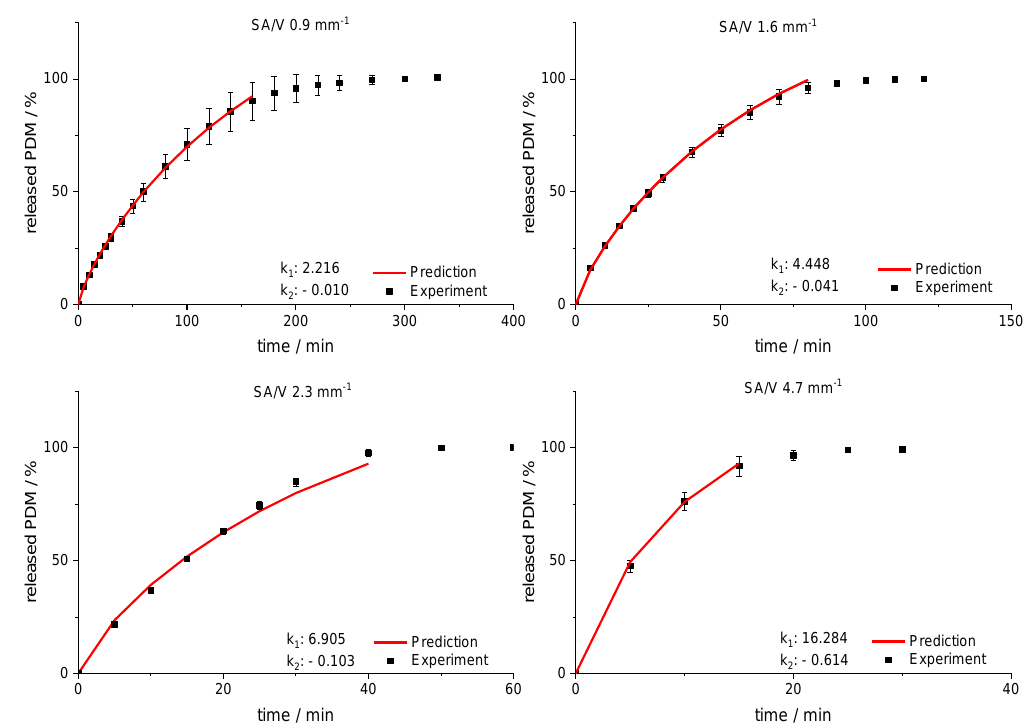
Figure 8. Predicted PDM release profiles vs. experimental results for SA/V ratio 0.9 mm − 1 , 1.6 mm − 1 , 2.3 mm − 1 and 4.67 mm − 1 of the PVA-PDM formulation.